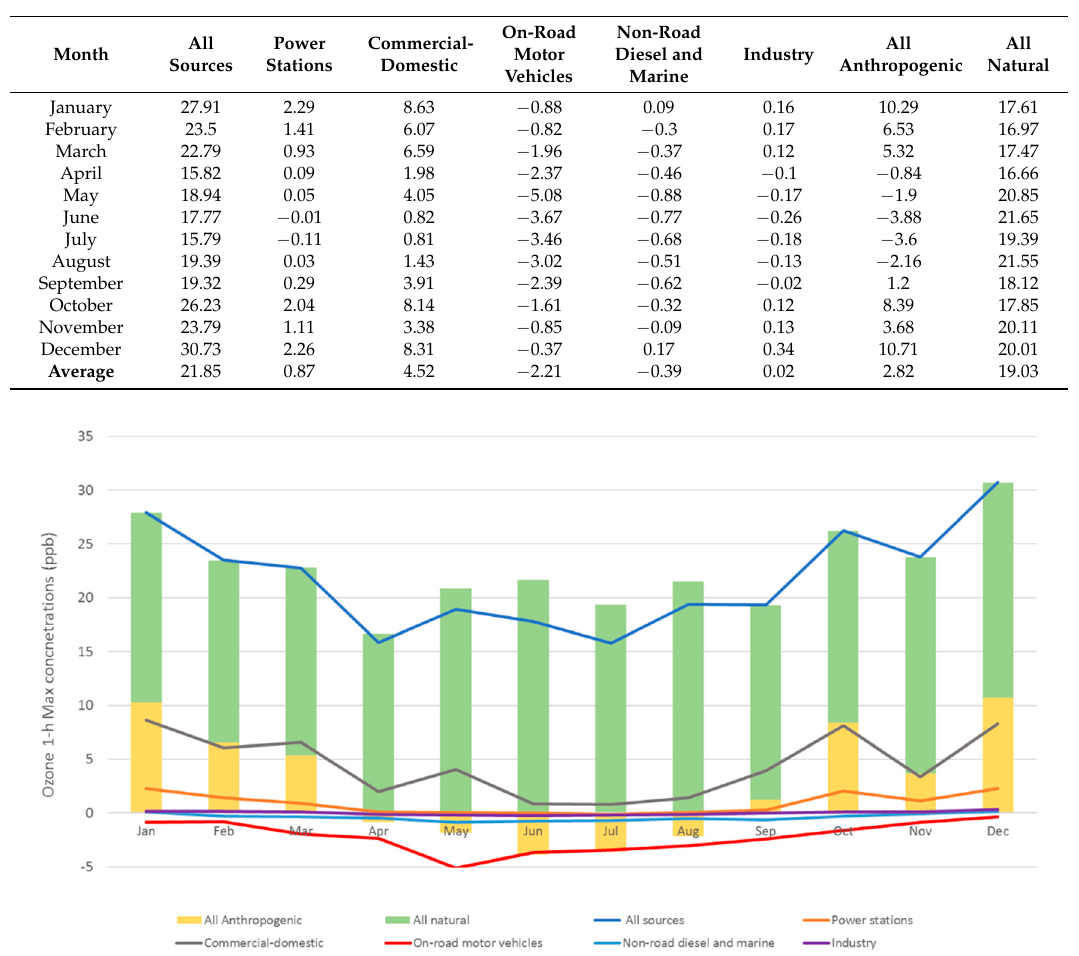
Figure A5. Contribution of all anthropogenic and natural emissions (bar graph) and different anthropogenic sources (line graph) to the monthly average of daily maximum 1-h ozone concentration in 2008 in the Sydney east region.